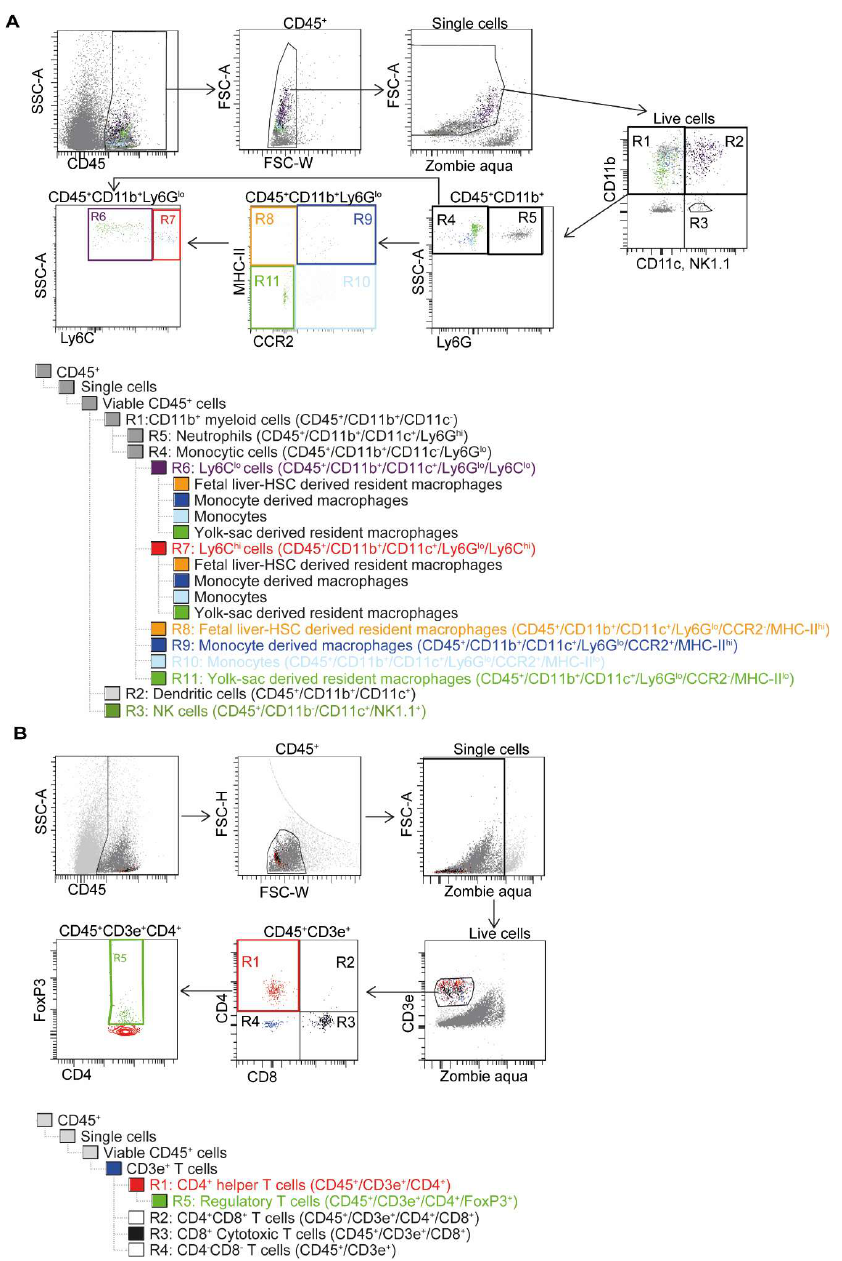
Figure 1. Gating strategy for identifying the specific immune subpopulations using Flow cytometry. Firstly, the mononuclear cells (MNC) that express CD45 were gated and only single cells were included into the analysis. Dead cells were excluded using Zombie-AmCyan dye. The remaining viable CD45 + MNCs were further characterized based on the expression of specific markers using two di ff erent panels: ( A ) Myeloid panel, ( B ) T cell panel. In both cases, only CD45 expressing mononuclear single-cell suspensions was included. In the myeloid panel, the live cells were then grouped based on their specific marker expression: R1: CD11b + myeloid cells, R2: Dendritic cells, R3: NK cells, R4: Monocytic cells, R5: Neutrophils, R6: Ly6C hi or commonly known as M1 cells, R7: Ly6C lo or commonly known as M2 cells, R8: Fetal liver-HSC derived resident macrophages, R9: Monocyte derived macrophages, R10: Monocytes, R11: Yolk-sac derived resident macrophages. In the T cell panel, the viable CD45 + cells were then gated for T cells based on the expression of CD3e. The T cells were then further grouped based on their specific marker expression combinations: R1: CD4 + helper T cells, R2: CD4 + CD8 + T cells, R3: CD8 + Cytotoxic T cells, R4: CD4 - CD8 - T